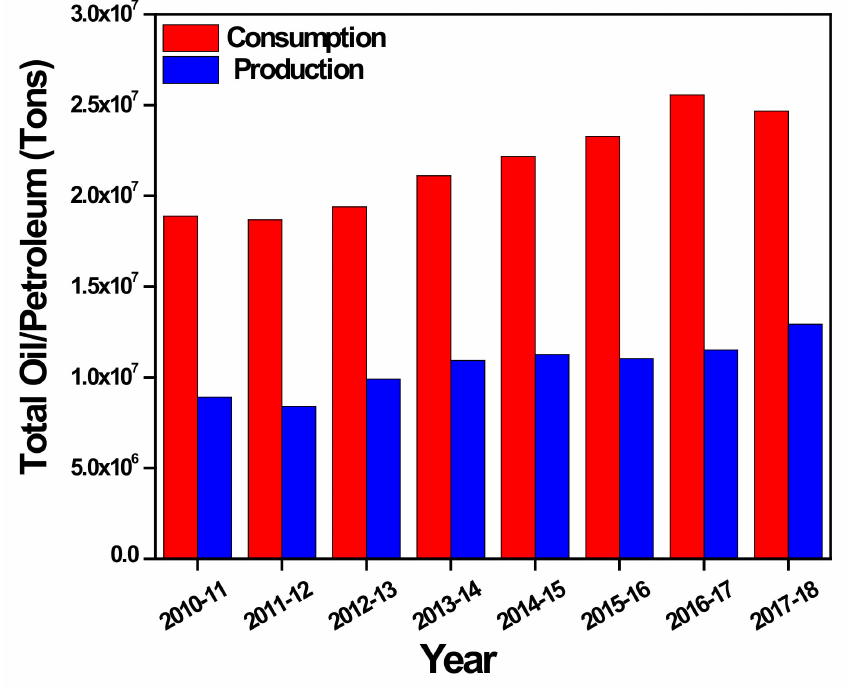
Figure 4. Total production and consumption of oil/petroleum in Pakistan